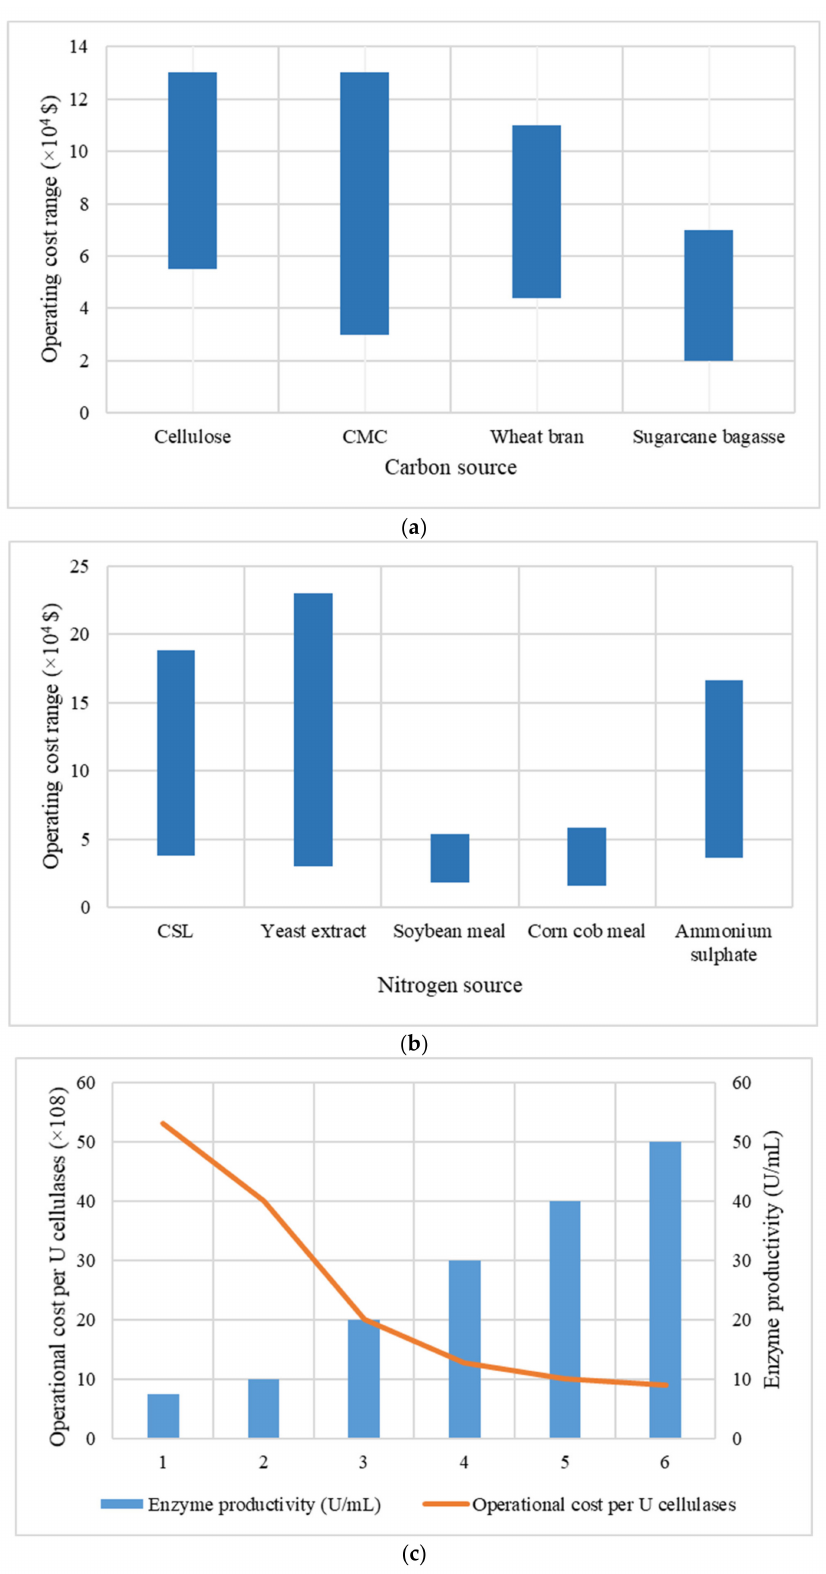
Figure 6. ( a ) Operational cost variations with utilization of different carbon sources in 1000 m 3 scale cellulase production. ( b ) Operational cost variations with utilization of different nitrogen sources in 1000 m 3 scale cellulase production. ( c ) Variations of operational cost with varying productivities of